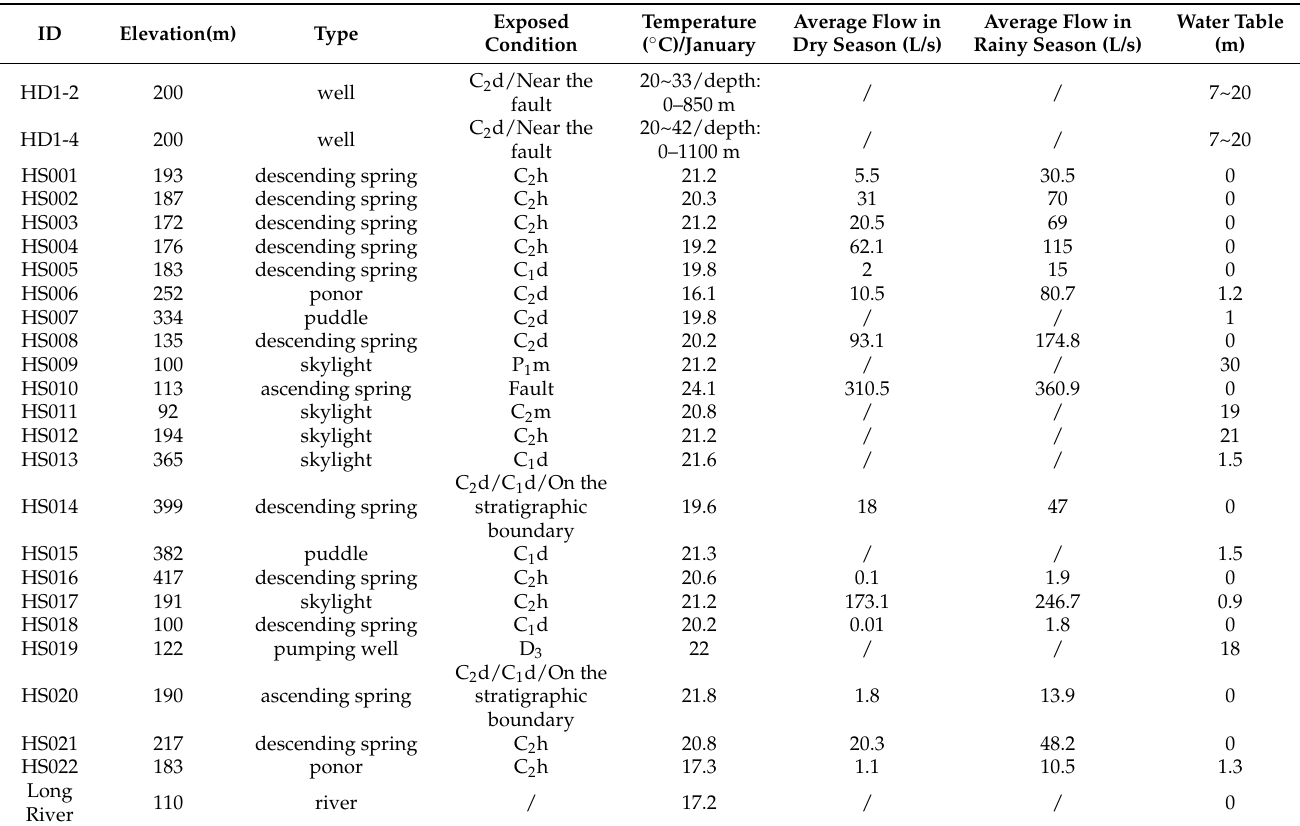
Table 1. Hydrogeological information and field test results of sampling points in Huanjiang